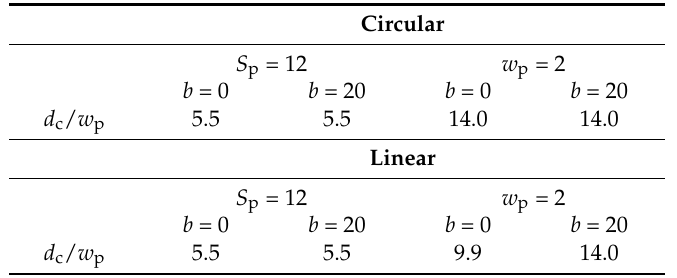
Table 2. Values of the ratio d c / w p under which the chains spread from single to multiple occupancy in the post arrays of the constant post separation S p and of the constant passage width w p